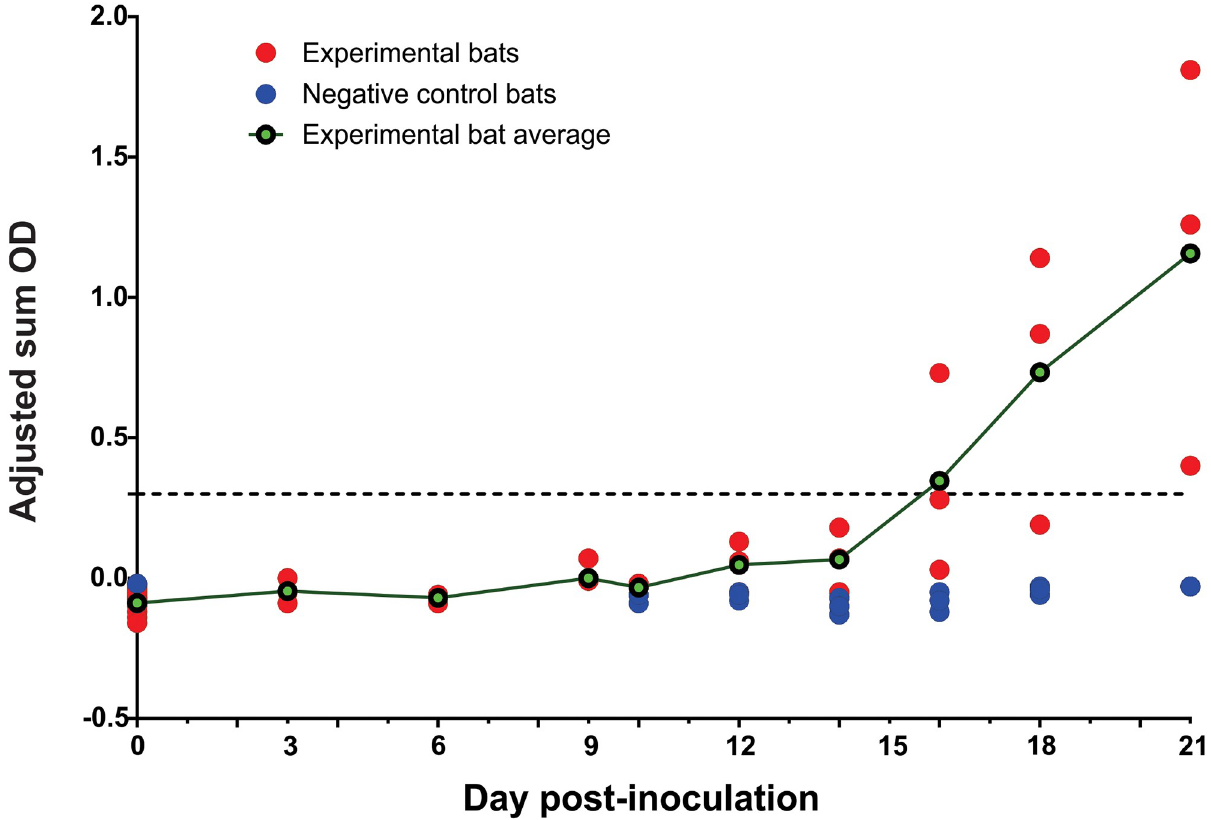
Fig 4. Sosuga virus antibody detected in inoculated bats. Serology results using an infectious based Sosuga virus antigen and anti-goat IgG. Sosuga virus IgG antibodies measured by indirect ELISA assay are shown as adjusted sum optical density (OD) values by day post-inoculation (DPI) for all infected bats (n = 12) at the time of euthanasia (0–9 DPI) and every other day beginning on 10 DPI for bats euthanized on 21 DPI. Results were considered positive (seroconversion) at a sum OD of �